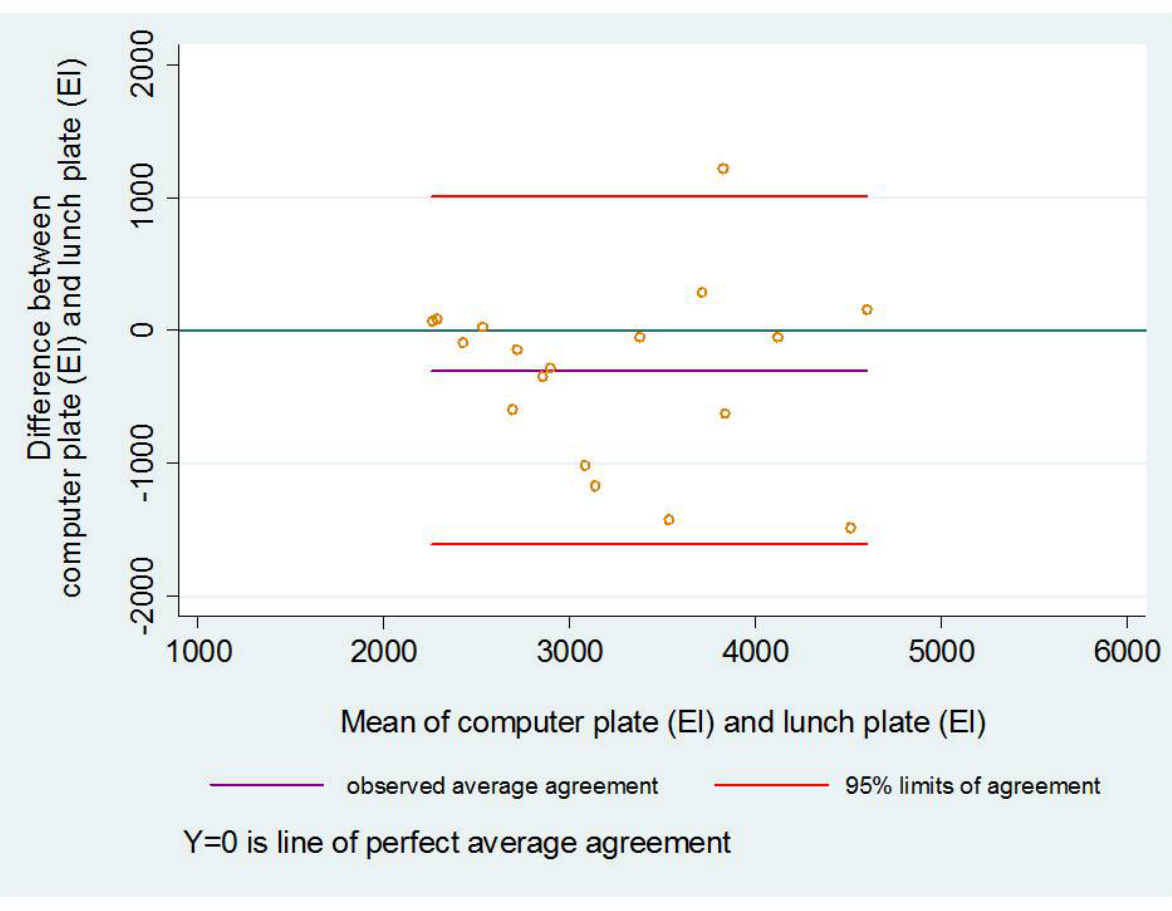
Figure 3. Bland-Altman plot of differences between total energy intake (EI, kJ) of the computer plate and the real lunch plate against the mean of EI (kJ) for each participant with a BMI < 25 kg/m2